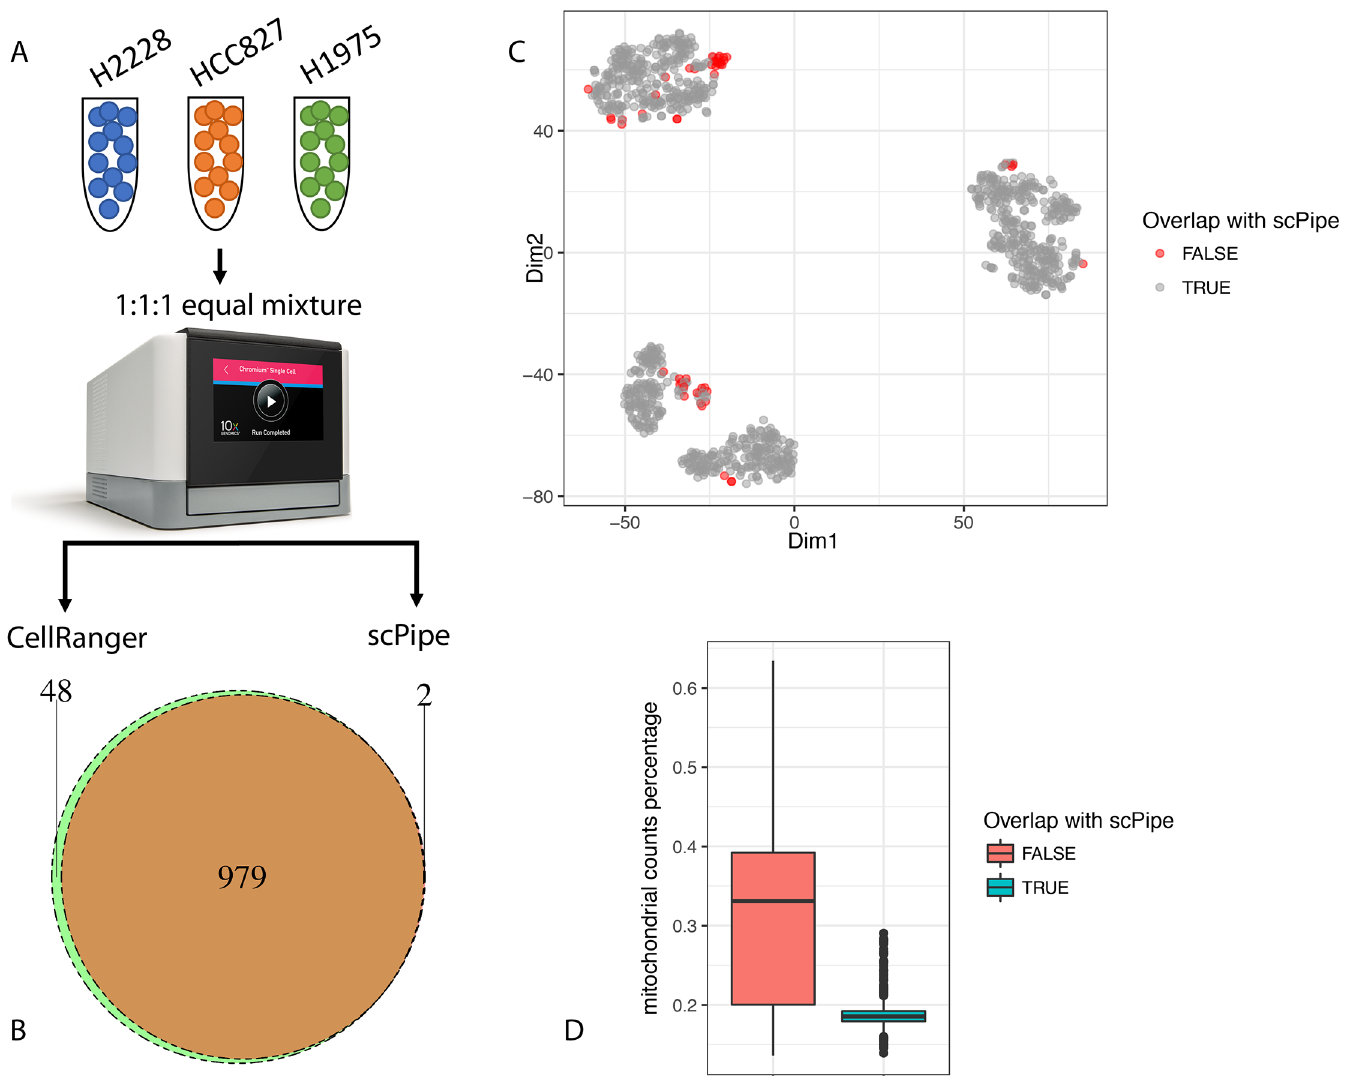
Fig 6. Comparing scPipe and CellRanger . ( A ) The workflow for the comparison. An equal mixture of cells from three cell lines are sequenced using the Chromium 10X platform (see Materials and methods). Data were processed by scPipe and CellRanger . ( B ) The pie chart shows the overlap of cell barcode detected by scPipe and CellRanger . ( C ) The t-SNE plot generated using CellRanger output. Cell barcodes that only exist in CellRanger are highlighted. ( D ) Box plots showing the percentage of mitochondrial gene counts in cells that overlap with scPipe or only exist in the CellRanger results.